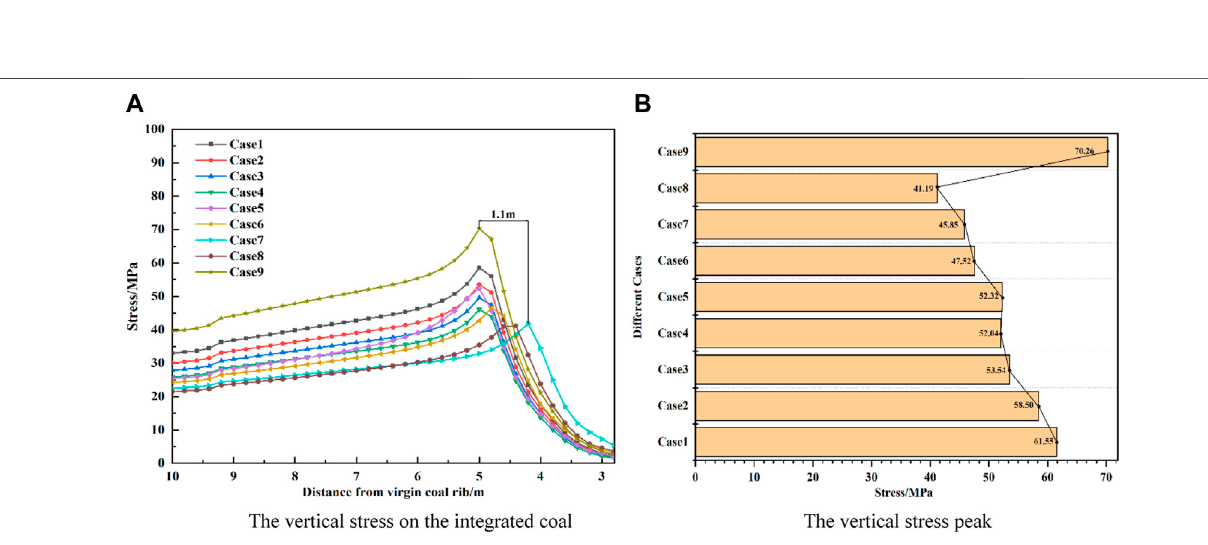
FIGURE 13 | Elastic zone area in the roadway. (A) The elastic zone in the roof (B) The elastic zone in the back fi lling body.